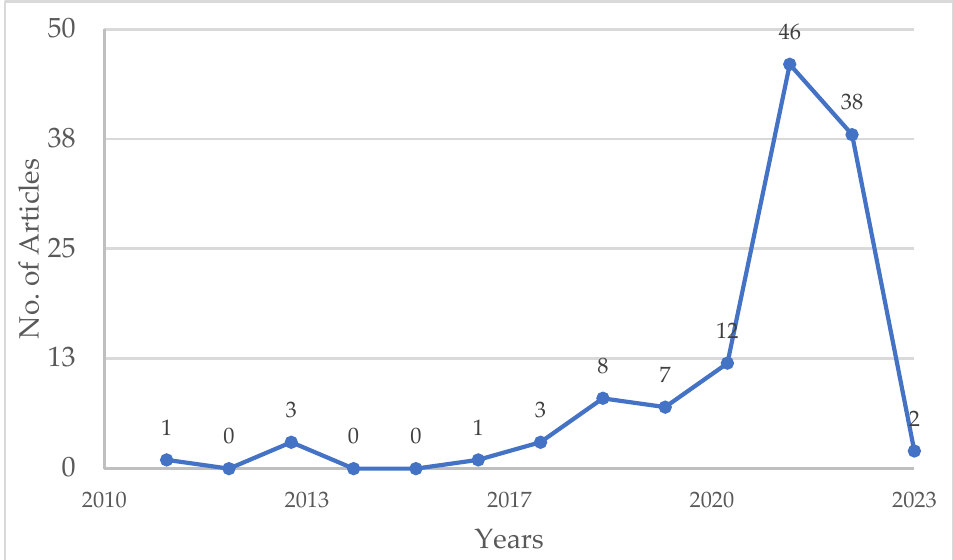
Figure 4. Annual scientific production. Source: created by the authors.